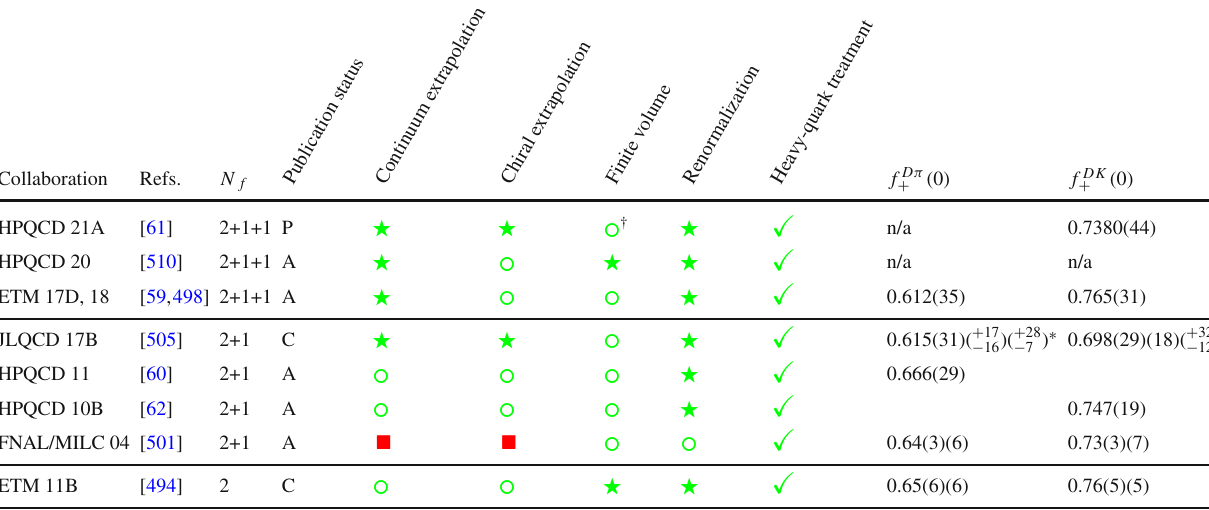
Table 35 Summary of computations of charmed-meson semileptonic form factors. Note that HPQCD 20 (discussed in Sect. 7.4) addresses the B c → B s and B c → B d transitions – hence the absence of quoted values for f D π + ( 0 ) and f DK + ( 0 ) – while ETM 18 provides a computation of tensor form